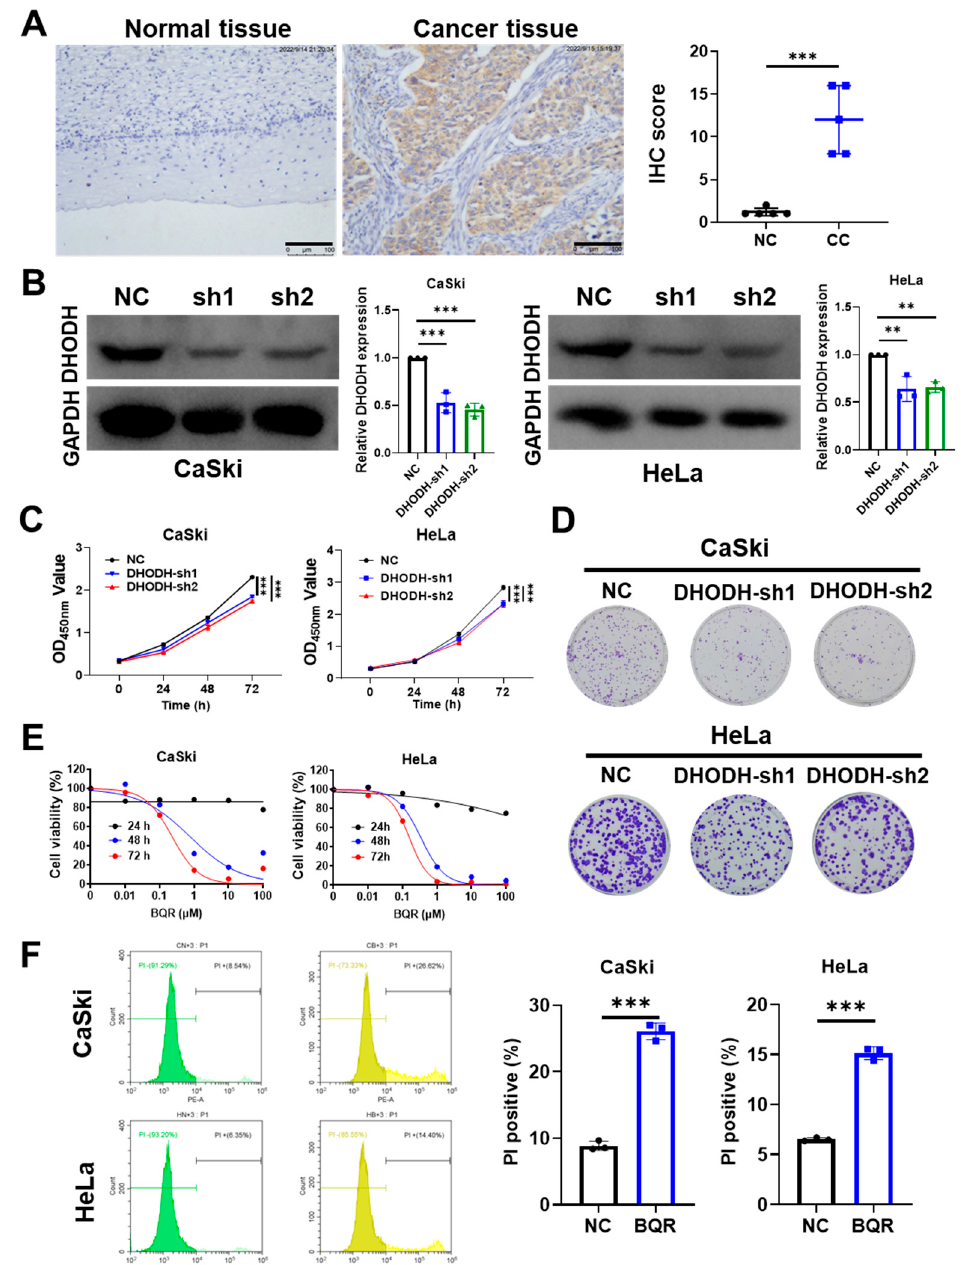
Figure 1. Inhibition of DHODH suppresses cell proliferation and promotes cell death in cervical cancer cells. ( A ) The expression level of DHODH protein in human cervical cancer tissues and adjacent non-tumor tissues was measured by IHC staining. Scale bar = 100 μ m. IHC scores were used to analyze the experimental results. *** p < 0.001 compared to the normal tissues. ( B ) The efficacy of DHODH knockdown in CaSki and HeLa cells was measured by Western blotting. The relative expression of DHODH was calculated by ImageJ software in each group ( n = 3). ** p < 0.01, *** p < 0.001 compared to the control group. ( C ) The effect of DHODH knockdown on cell viability was measured by CCK-8 assays in cervical cancer cells. *** p < 0.001 compared to the control group. ( D ) The effect of DHODH knockdown on clonogenicity was measured by the colony formation assay in cervical cancer cells. ( E ) Sensitivity to brequinar (BQR) was assessed using the CCK-8 assay in CaSki and HeLa cells treated with BQR (0, 0.01, 0.1, 1, 10, 100 μ M) for 24, 48 and 72 h. ( F ) The effect of BQR (0.7 μ M for CaSki cells; 0.3 μ M for HeLa cells) on cell death was assessed by the flow cytometry analysis through PI staining. *** p < 0.001 compared to the control group.